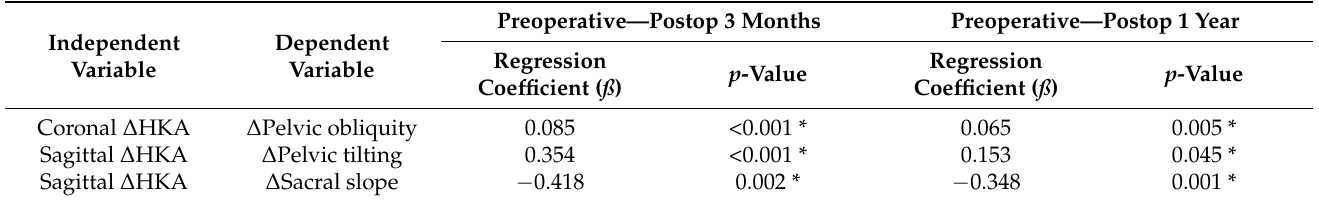
Table 3. Subgroup analysis to identify the cause–result relationship using linear regression analysis.